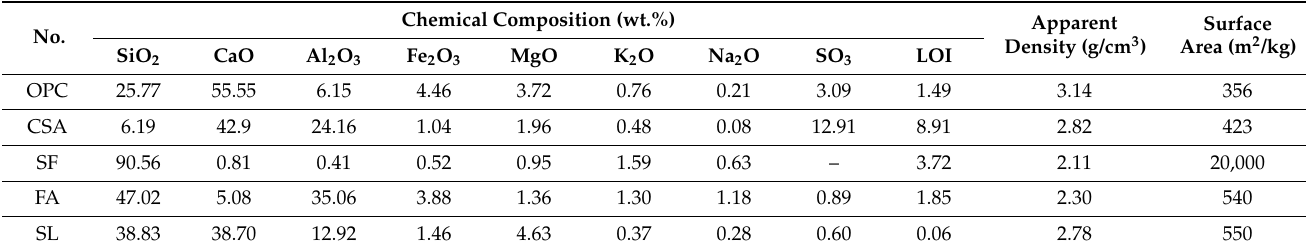
Table 1. Chemical composition and physical properties of the cementitious